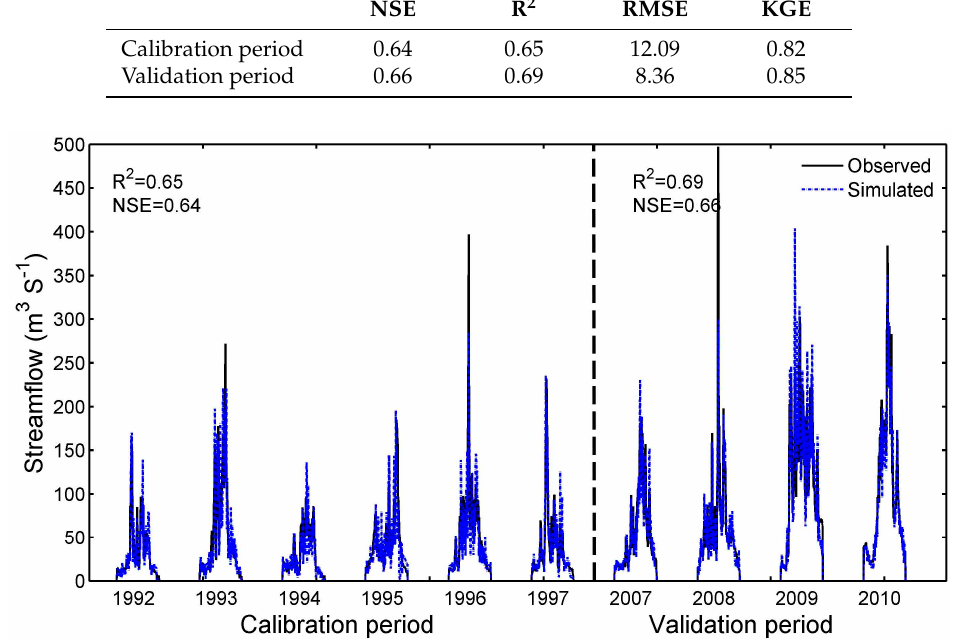
Figure 3. The simulation results for calibration and validation periods.